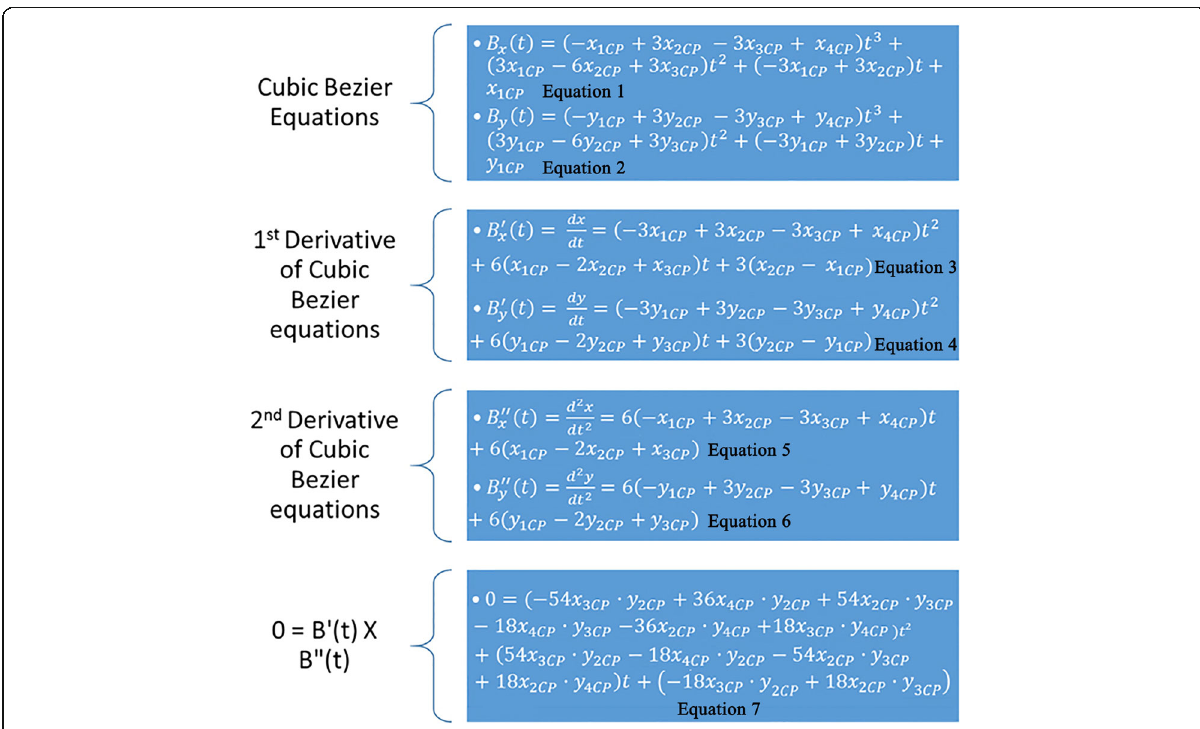
Fig. 3 x 1CP , x 2CP , x 3CP , and x 4CP stand respectively for the x coordinate value of the first, second, third, and fourth control points of the respective cubic poly-Bezier curve (first or second). y 1CP , y 2CP , y 3CP , and y 4CP stand respectively for the y coordinate value of the first, second, third, and fourth control points of the respective cubic poly-Bezier curve. The parameter t in all the equations below lies between 0 ≤ t ≤ 1. The first and second equations are the equations of the x and y components of the cubic Bezier curve respectively, while the third and fourth equations are their first derivatives, respectively, and the fifth and sixth equations are the second derivatives. The position of the inflection points of a parametric cubic Bezier curve are among the solutions of the equation: B ′ ( t ) X B ″ ( t ) = B ′ x ( t ) • B